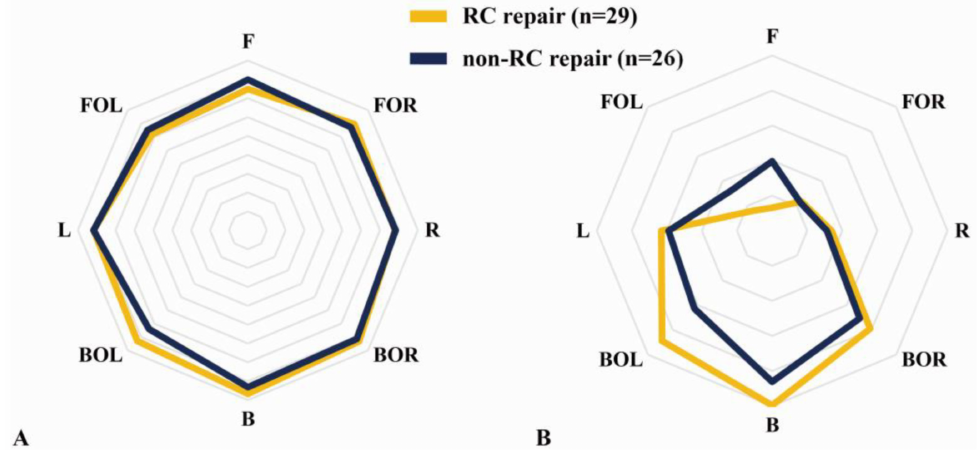
Figure 7. Subanalysis of core muscle asymmetry according to the difference between rotator cuff (RC) repair and non-RC repair. ( A ) Direction core muscle ratio (DCMR). ( B ) Core muscle state ratio